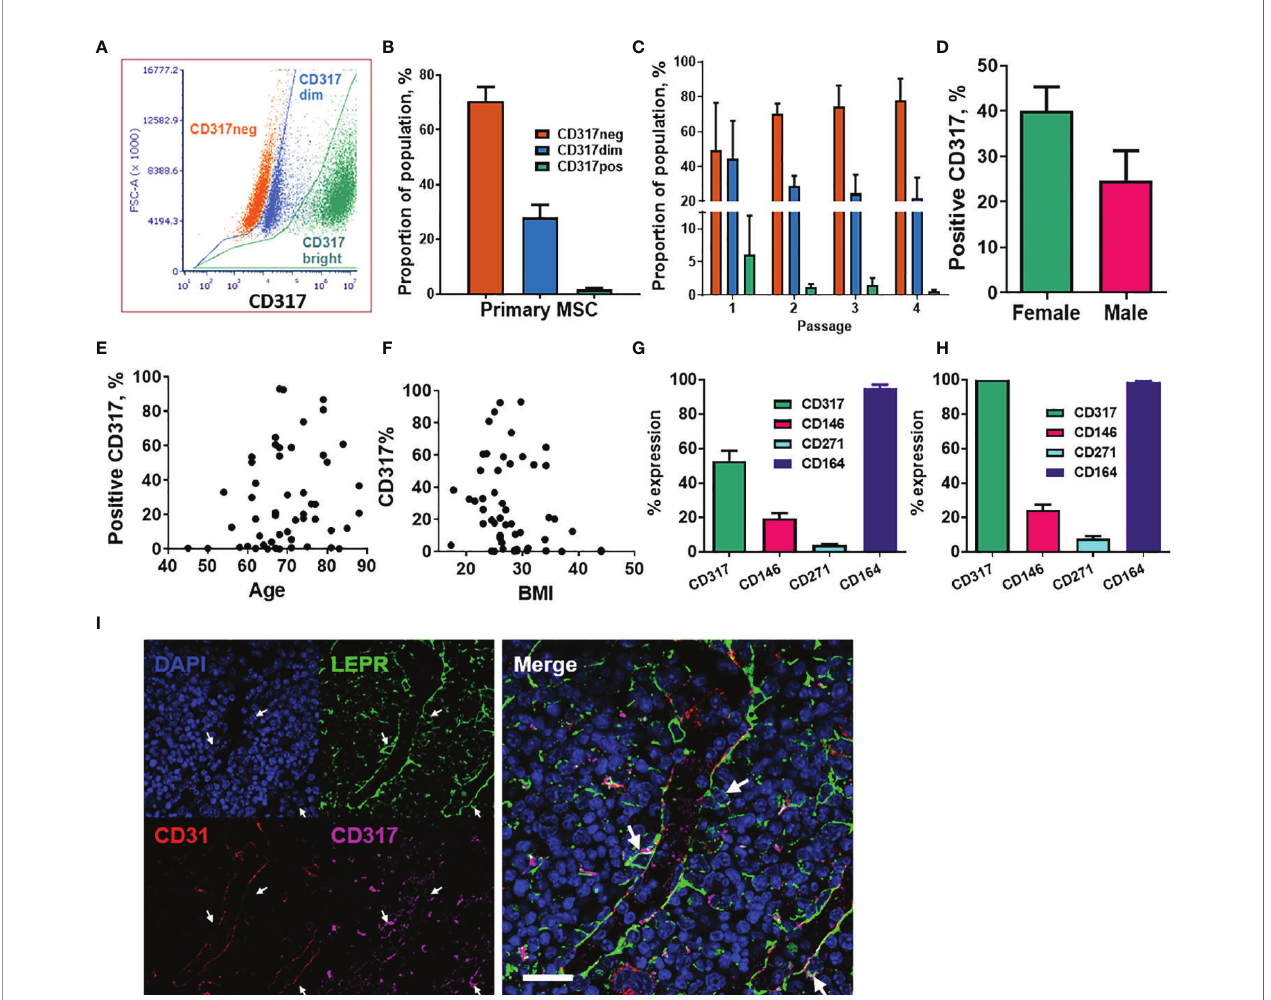
FIGURE 1 | Analysis of CD317-expressing MSC populations within primary cell isolates. (A) The CD317 expressing populations can be divided into CD317 bright and CD317 dim with CD317 bright MSCs. (B) Average proportions of CD317 neg and CD317 pos , comprising CD317 dim and CD317 bright , in primary MSCs lines. (C) Expression of CD317 over early passages 1 to 4 in Primary MSCs with CD317 neg increasing, CD317 dim and CD317 bright decreasing during in vitro culture (n=2-12). Variation of CD317 expression with gender (D) , age (E) and BMI (F) in primary donors (n=52). (G) Isolated MSCs from human primary donors showed CD317 pos (CD317 dim and CD317 bright combined) with mean values of CD317 pos , CD146 pos , CD271 pos and CD164 pos (n=27). (H) Examination of the CD317 pos population only, showed similar proportions of each marker to those seen in the whole population (n=27). (I) CD317 expression was detected throughout the bone marrow of mice with low frequency colocalization of CD317 and LEPR+ in peri-sinusoidal regions